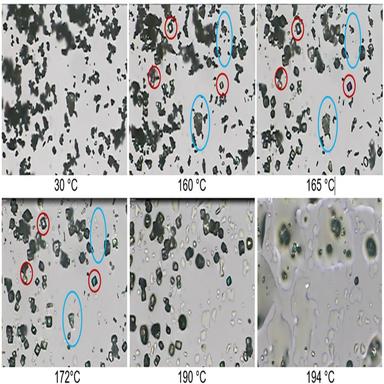
Hot stage microscopy of OLZ sample A, 200×, heating rate of 10 °C.min−1 .